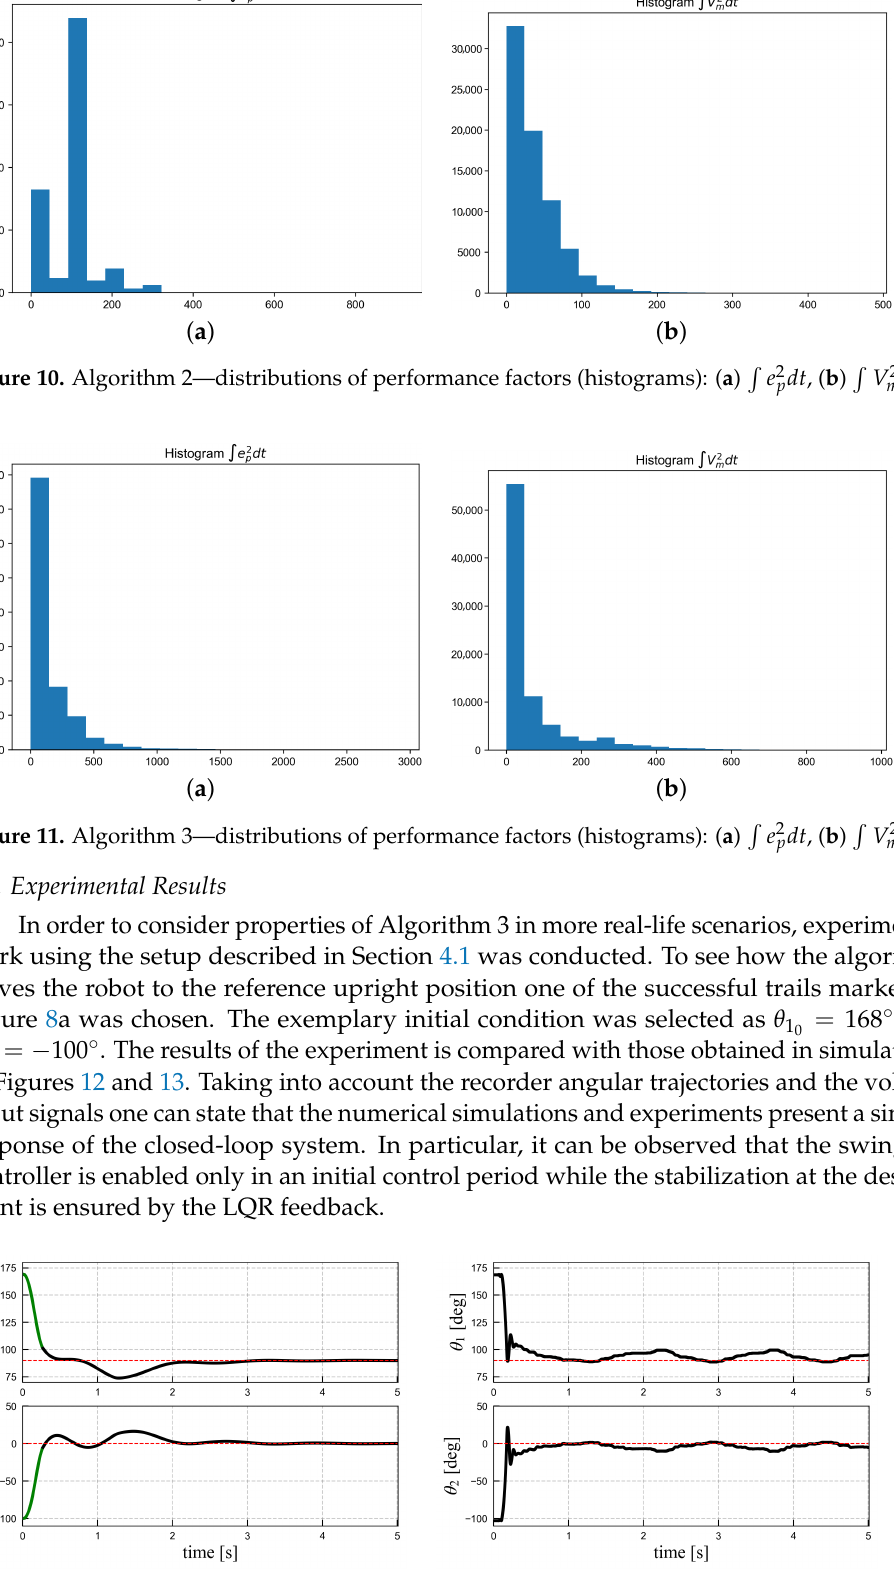
Figure 10. Algorithm 2—distributions of performance factors (histograms): ( a )